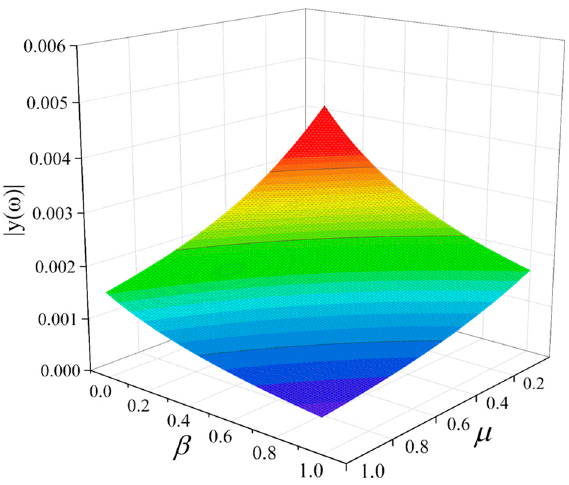
Figure 11. The influence of mass ratios and apparent mass ratios on the peak value of displacement response spectrums.